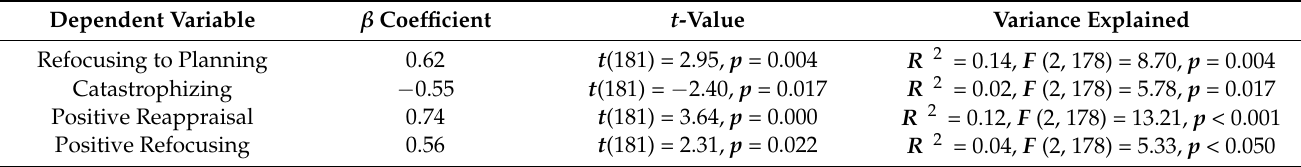
Table 2. Dependent variables that were significantly associated with social